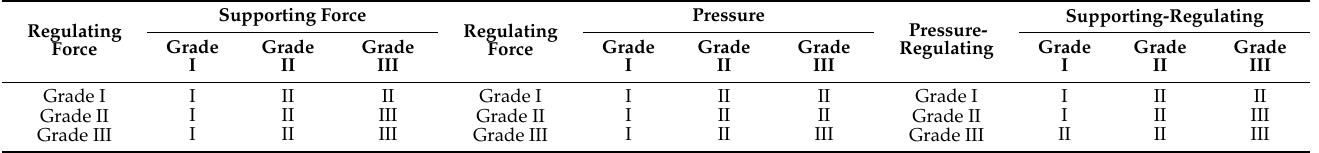
Table 2. Vulnerability risk matrix of